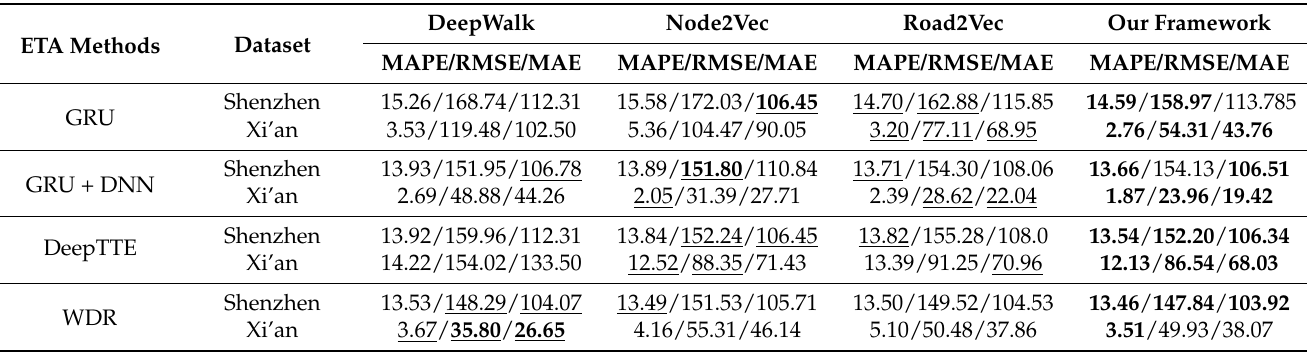
Table 3. Results of the baseline methods and our framework in the ETA determination task on the two datasets.